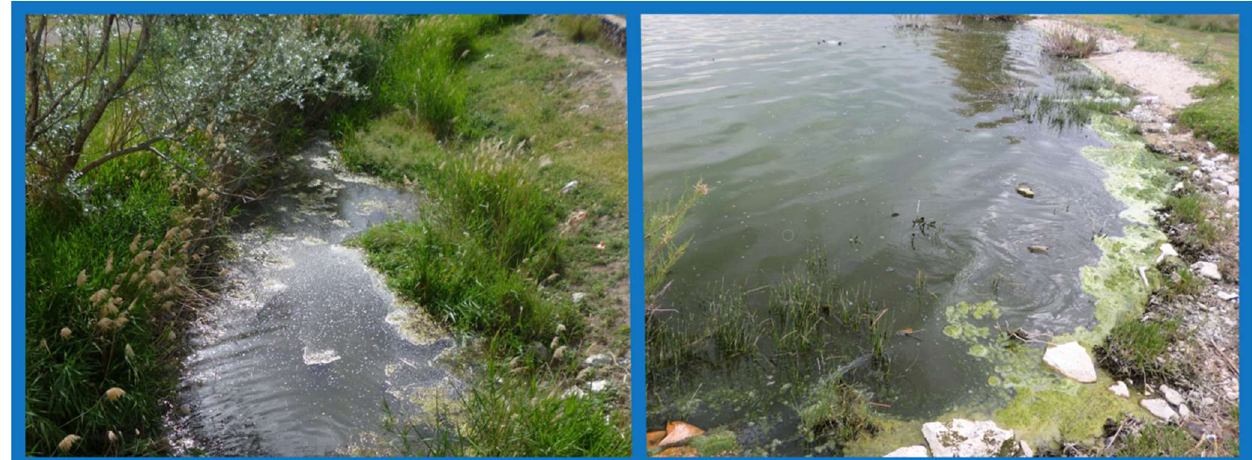
Figure 7. Algal blooms in Aksaray Input (on the left ), and Akkaya Dam (on the right ); photographed by Ahmet Altındağ on May 2014.